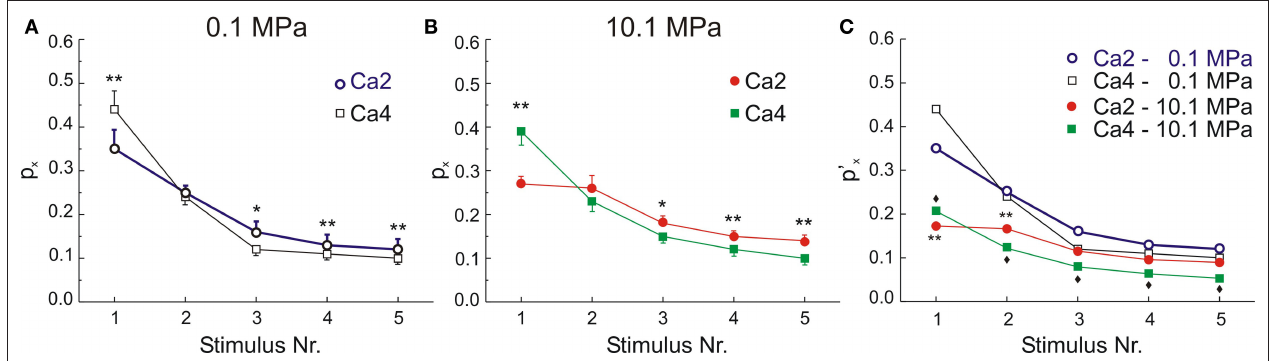
at the corresponding pressure is *p = 0.07 and **p < o